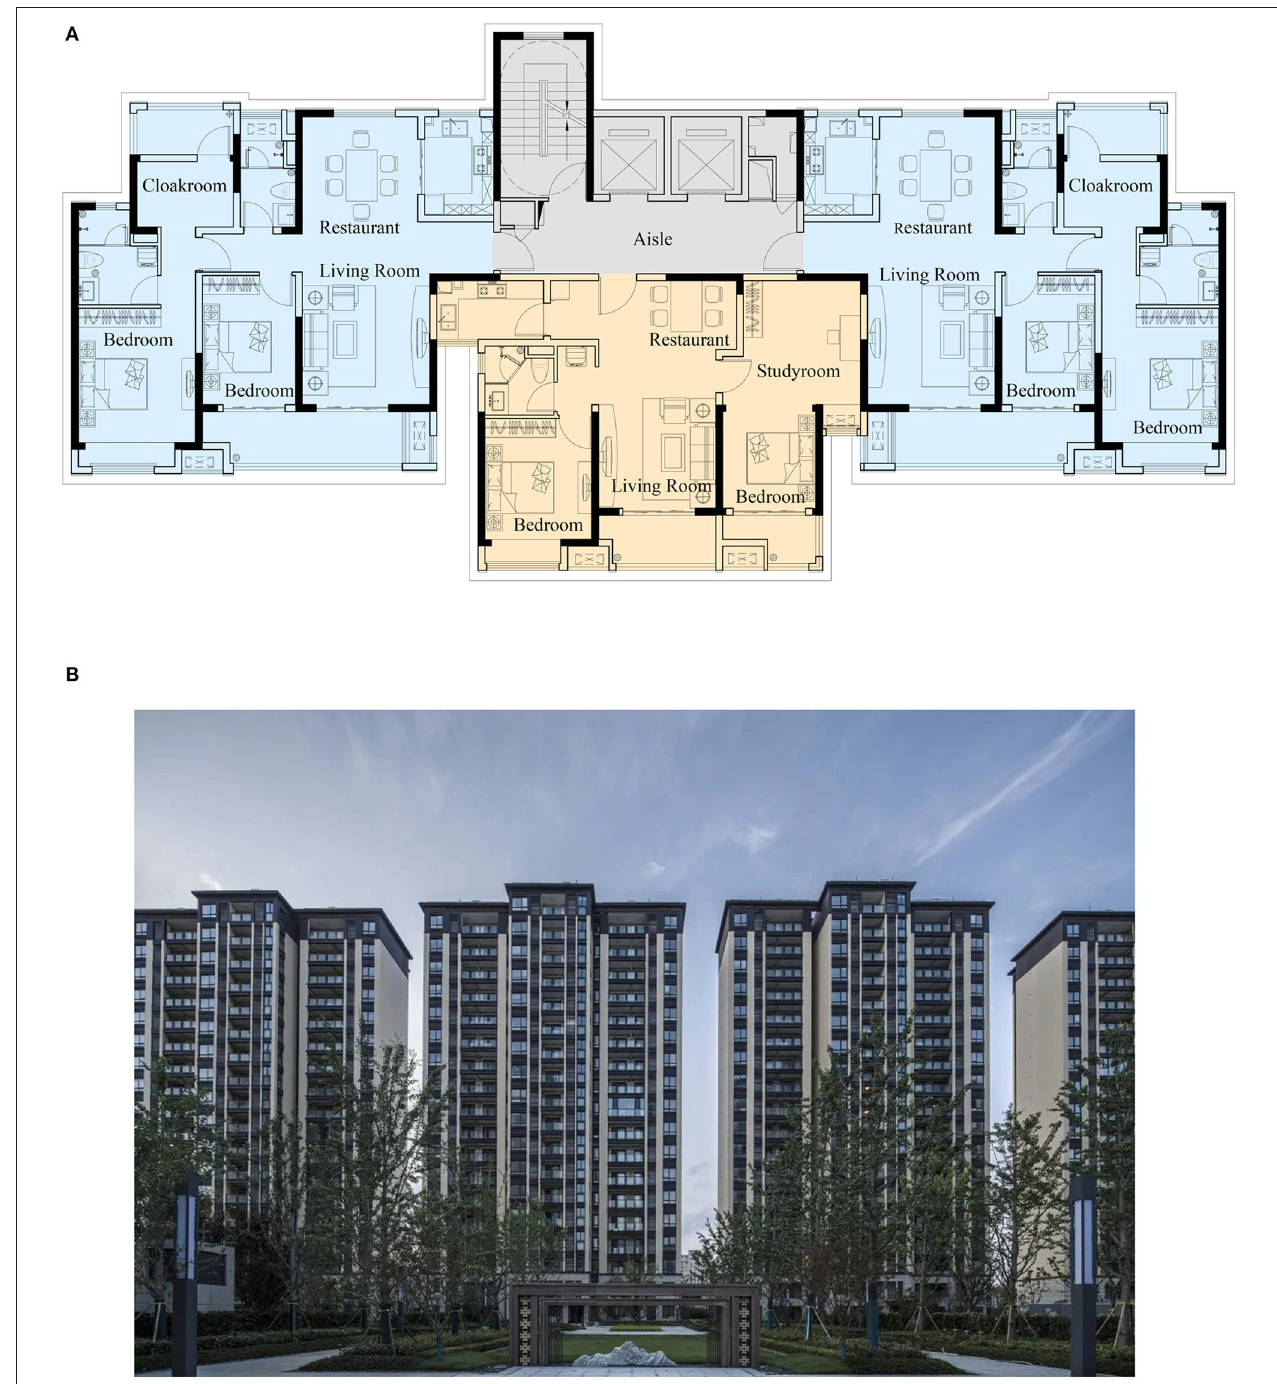
FIGURE 1 | Standard floor plan and facade of a typical MURB. (A) Standard floor plan of a typical MURB. (B) Façade of a typical MURBs.